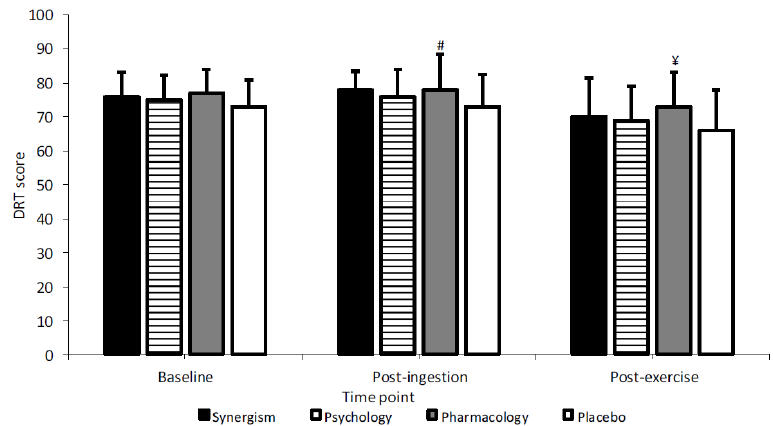
Figure 3. Mean dynamic reaction time (DRT) across treatments and time (# and ¥ denotes significantly greater difference vs. placebo).